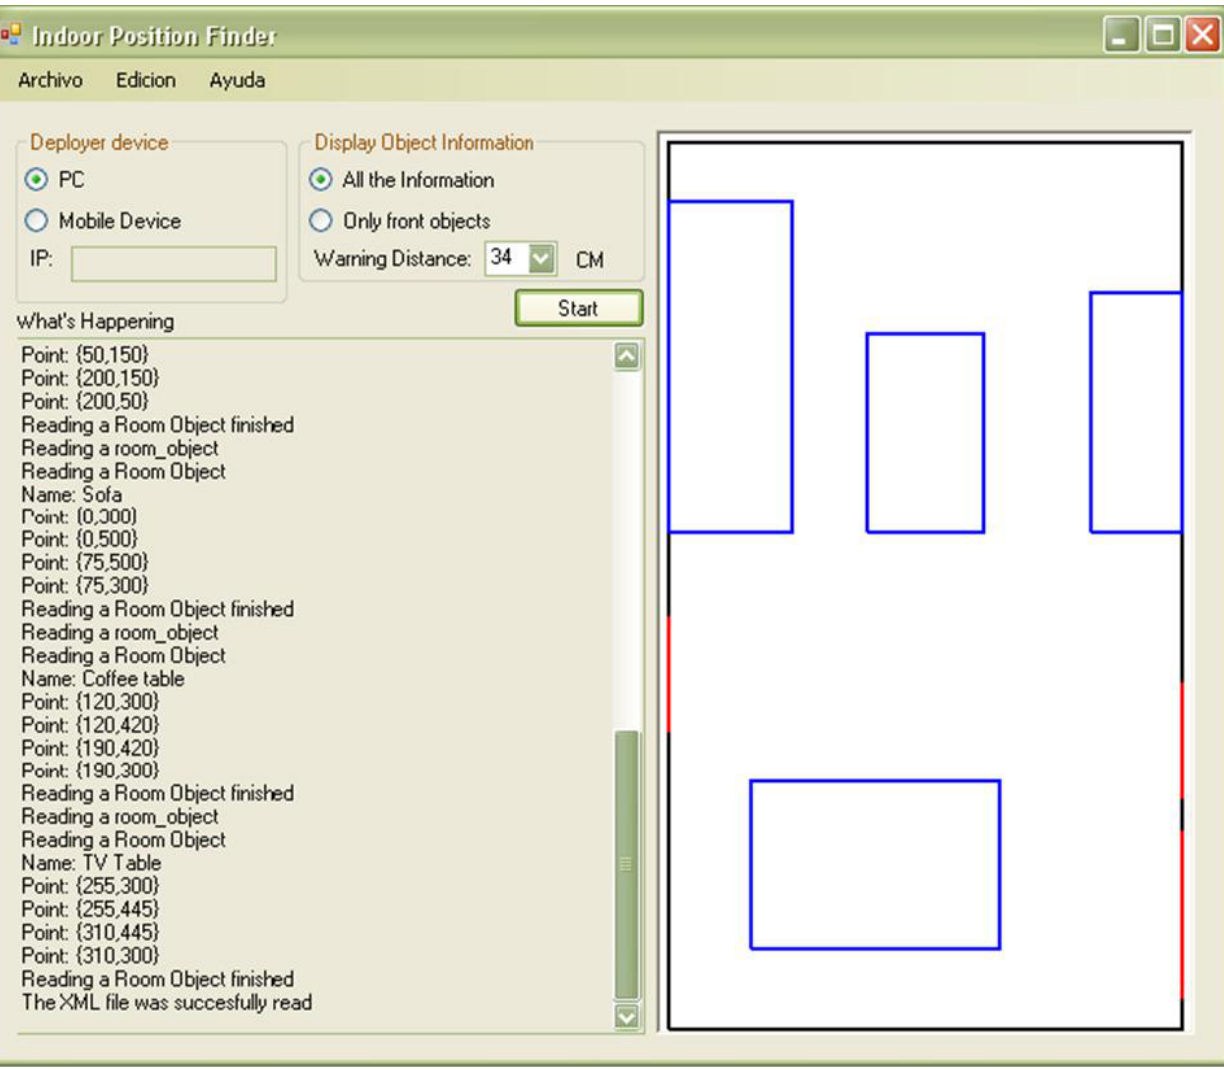
Figure 5. Application to describe indoor environments.